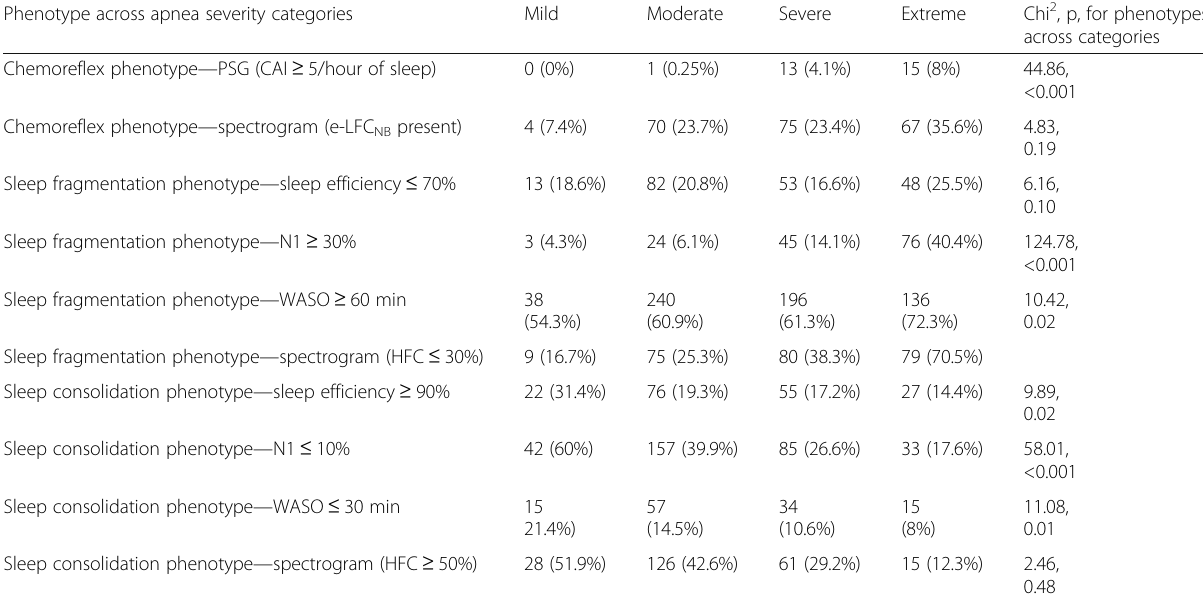
Table 6 Phenotypes across sleep apnea severity categories